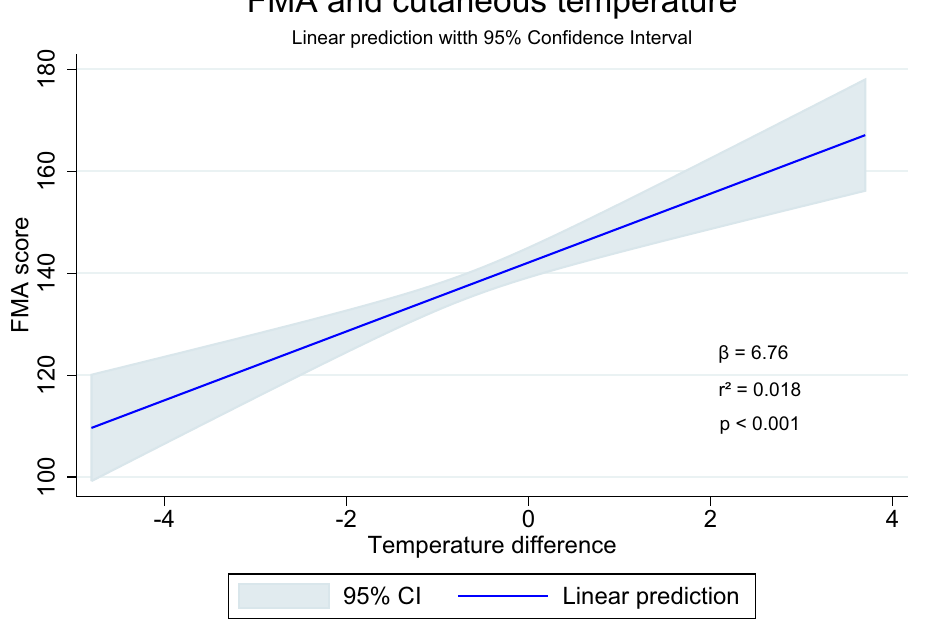
Figure 3. Linear prediction of sensorimotor recovery (FMA) over cutaneous temperature difference. Image obtained by the Stata14 program (https:// www. stata. com/ stata